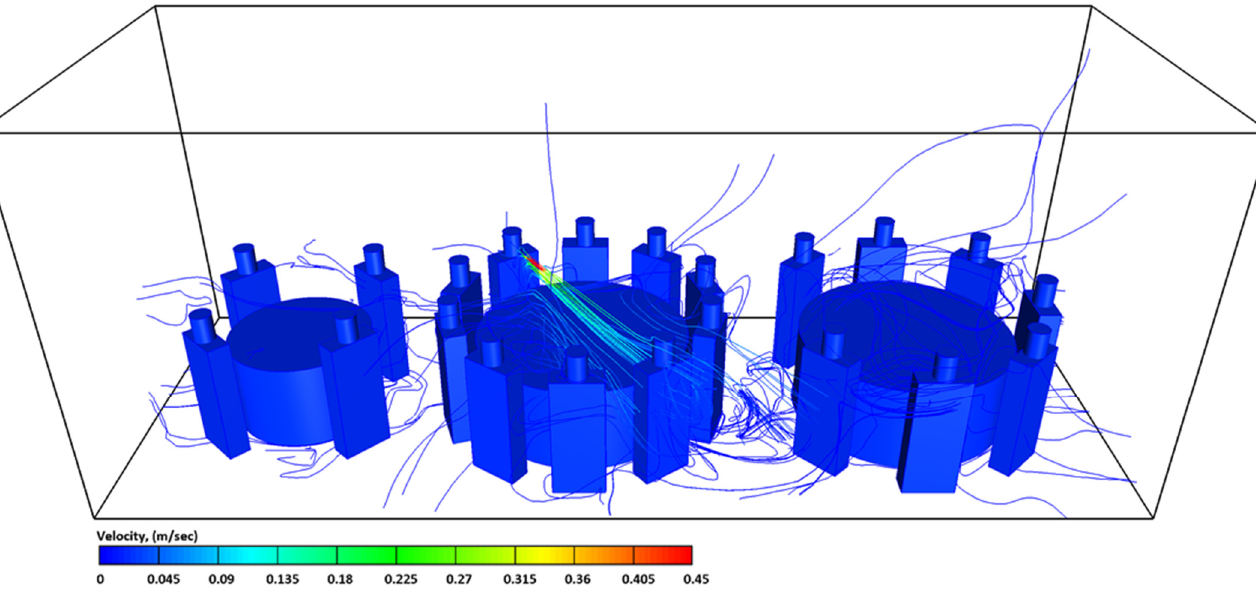
Figure 14. The airflow streamlines velocities in the computational domain at t = 4500 s for case-5.